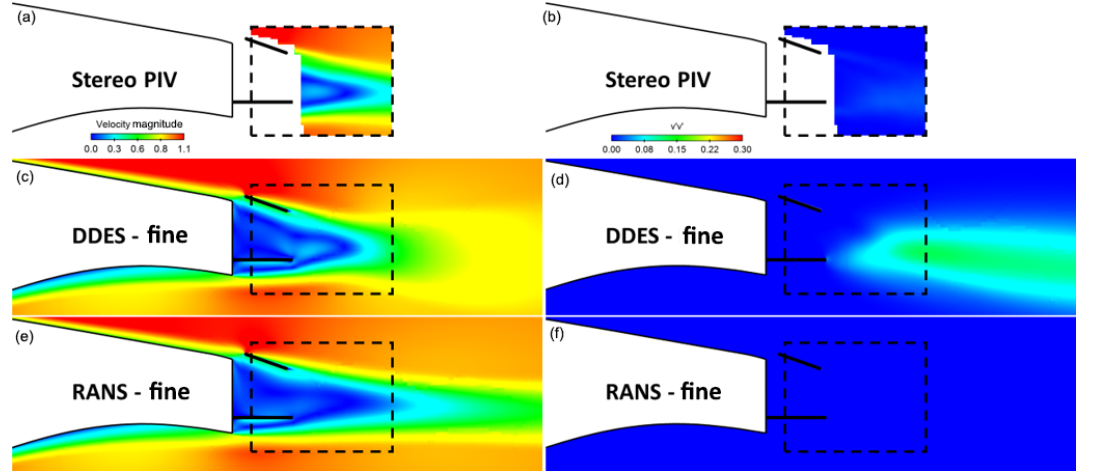
Figure 12. Flap + offset cavity case. Normalised velocity magnitude contours, V/V ∞ , (a, c, e) and v (cid:48) v (cid:48) /V 2 ∞ normal Reynolds stress con- tours (b, d, f) : comparison between stereo PIV, RANS and IDDES results. The fine mesh (25 million cells) was used in the